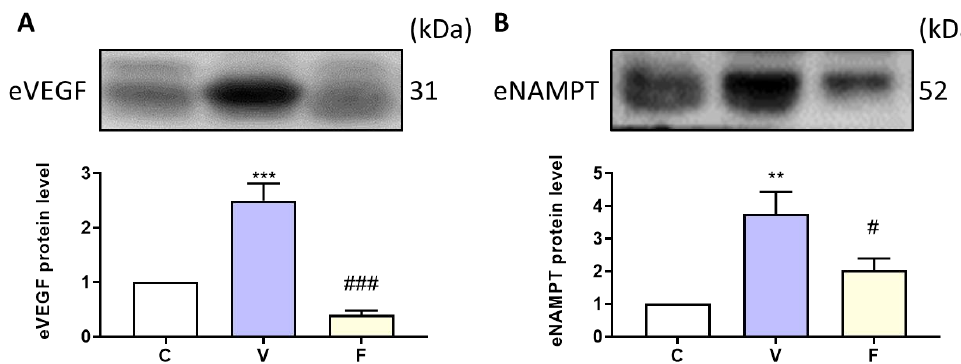
Figure 4. Effect of visfatin on serum angiogenesis marker and extracellular NAMPT expression. The protein expressions of ( A ) VEGF and ( B ) eNAMPT were analyzed by Western blot. Data are presented as mean ± SEM. C, control group. V, visfatin-induced group. F, visfatin + FK866 inhibitor group. ** p < 0.01 and *** p < 0.001 compared to C. # p < 0.05 and ### p < 0.001 compared to V.